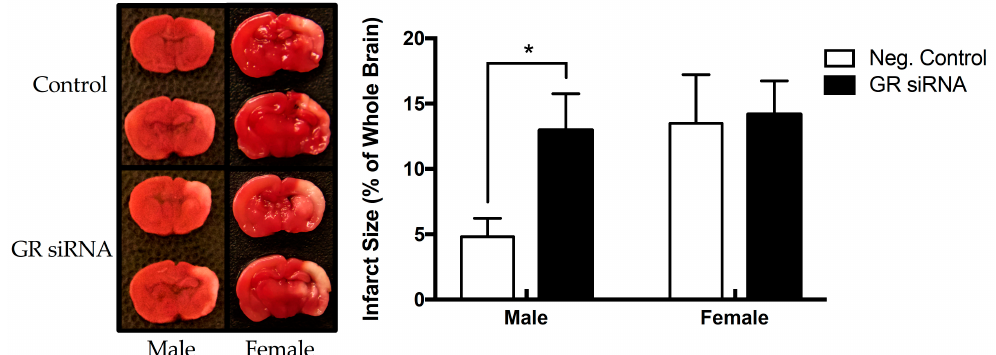
Figure 2. Knockdown of endogenous GR exacerbates mild HI injury in the male neonatal rat pup brain. GR siRNA (100 pmol) or negative control (100 pmol) was injected by ICV injection 48 h on postnatal day 7 (P7) before HI-injury. HI-injury was performed on postnatal day 9 (P9) for 60 min in 8% FiO 2 . We separated sex into the following groups: negative control (negative control: male, n = 5; female, n = 8) versus GR siRNA (male, n = 5; female, n = 11). In the male population, GR siRNA increased infarct volume. No significant di ff erence was seen in the female population, although the total brain injury was increased with a mild hypoxic-ischemic model. Data are means ± SEM, * p = 0.0315, GR siRNA vs. negative